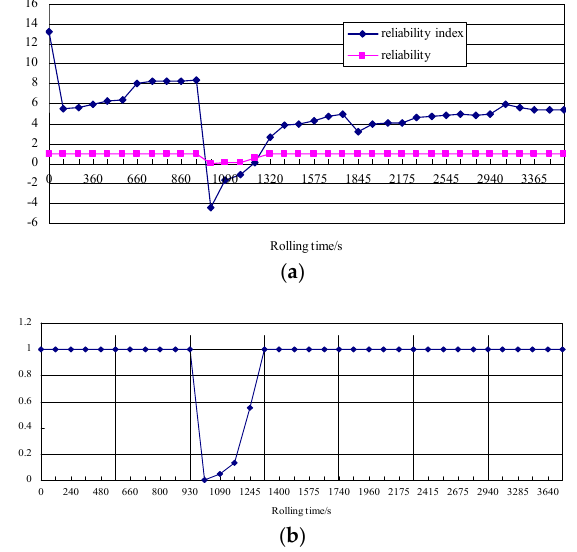
Figure 9. Reliability and reliability index of the sensor: ( a ) reliability index and reliability; ( b ) reliability associated with each rolling pass.